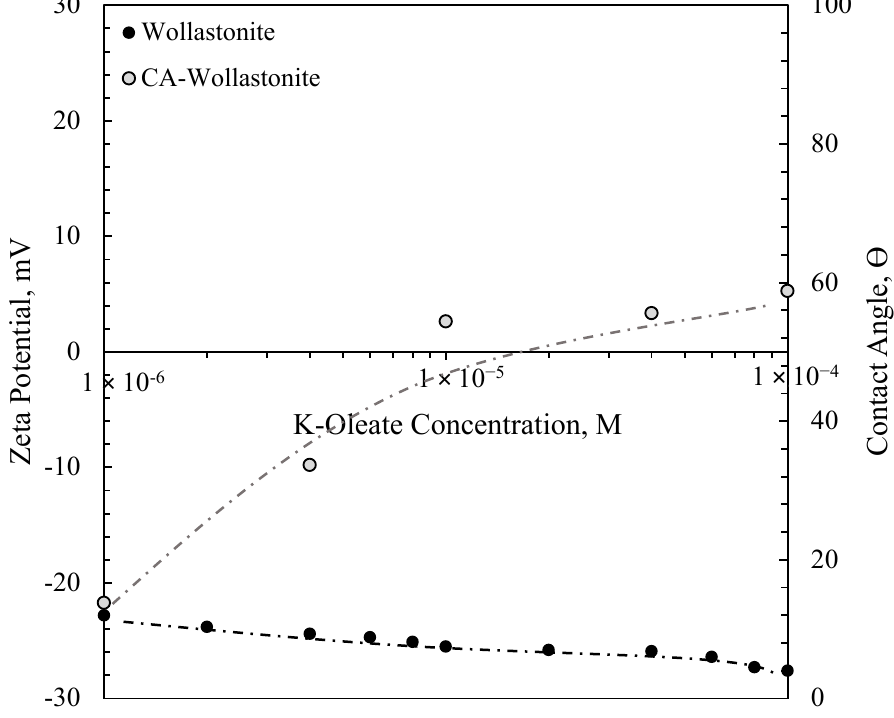
Figure 10. Combined presentation of contact angle and zeta potential measurements for wollastonite.